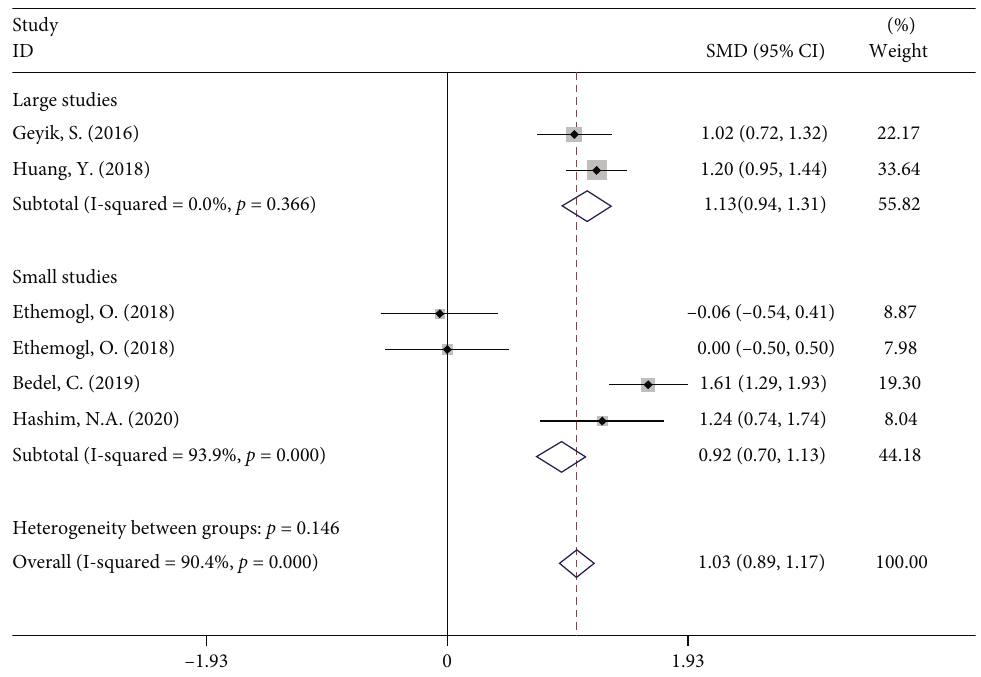
Figure 5: Subgroup analysis of di ff erences in NLR levels between GBS patients before treatment and healthy controls according to sample